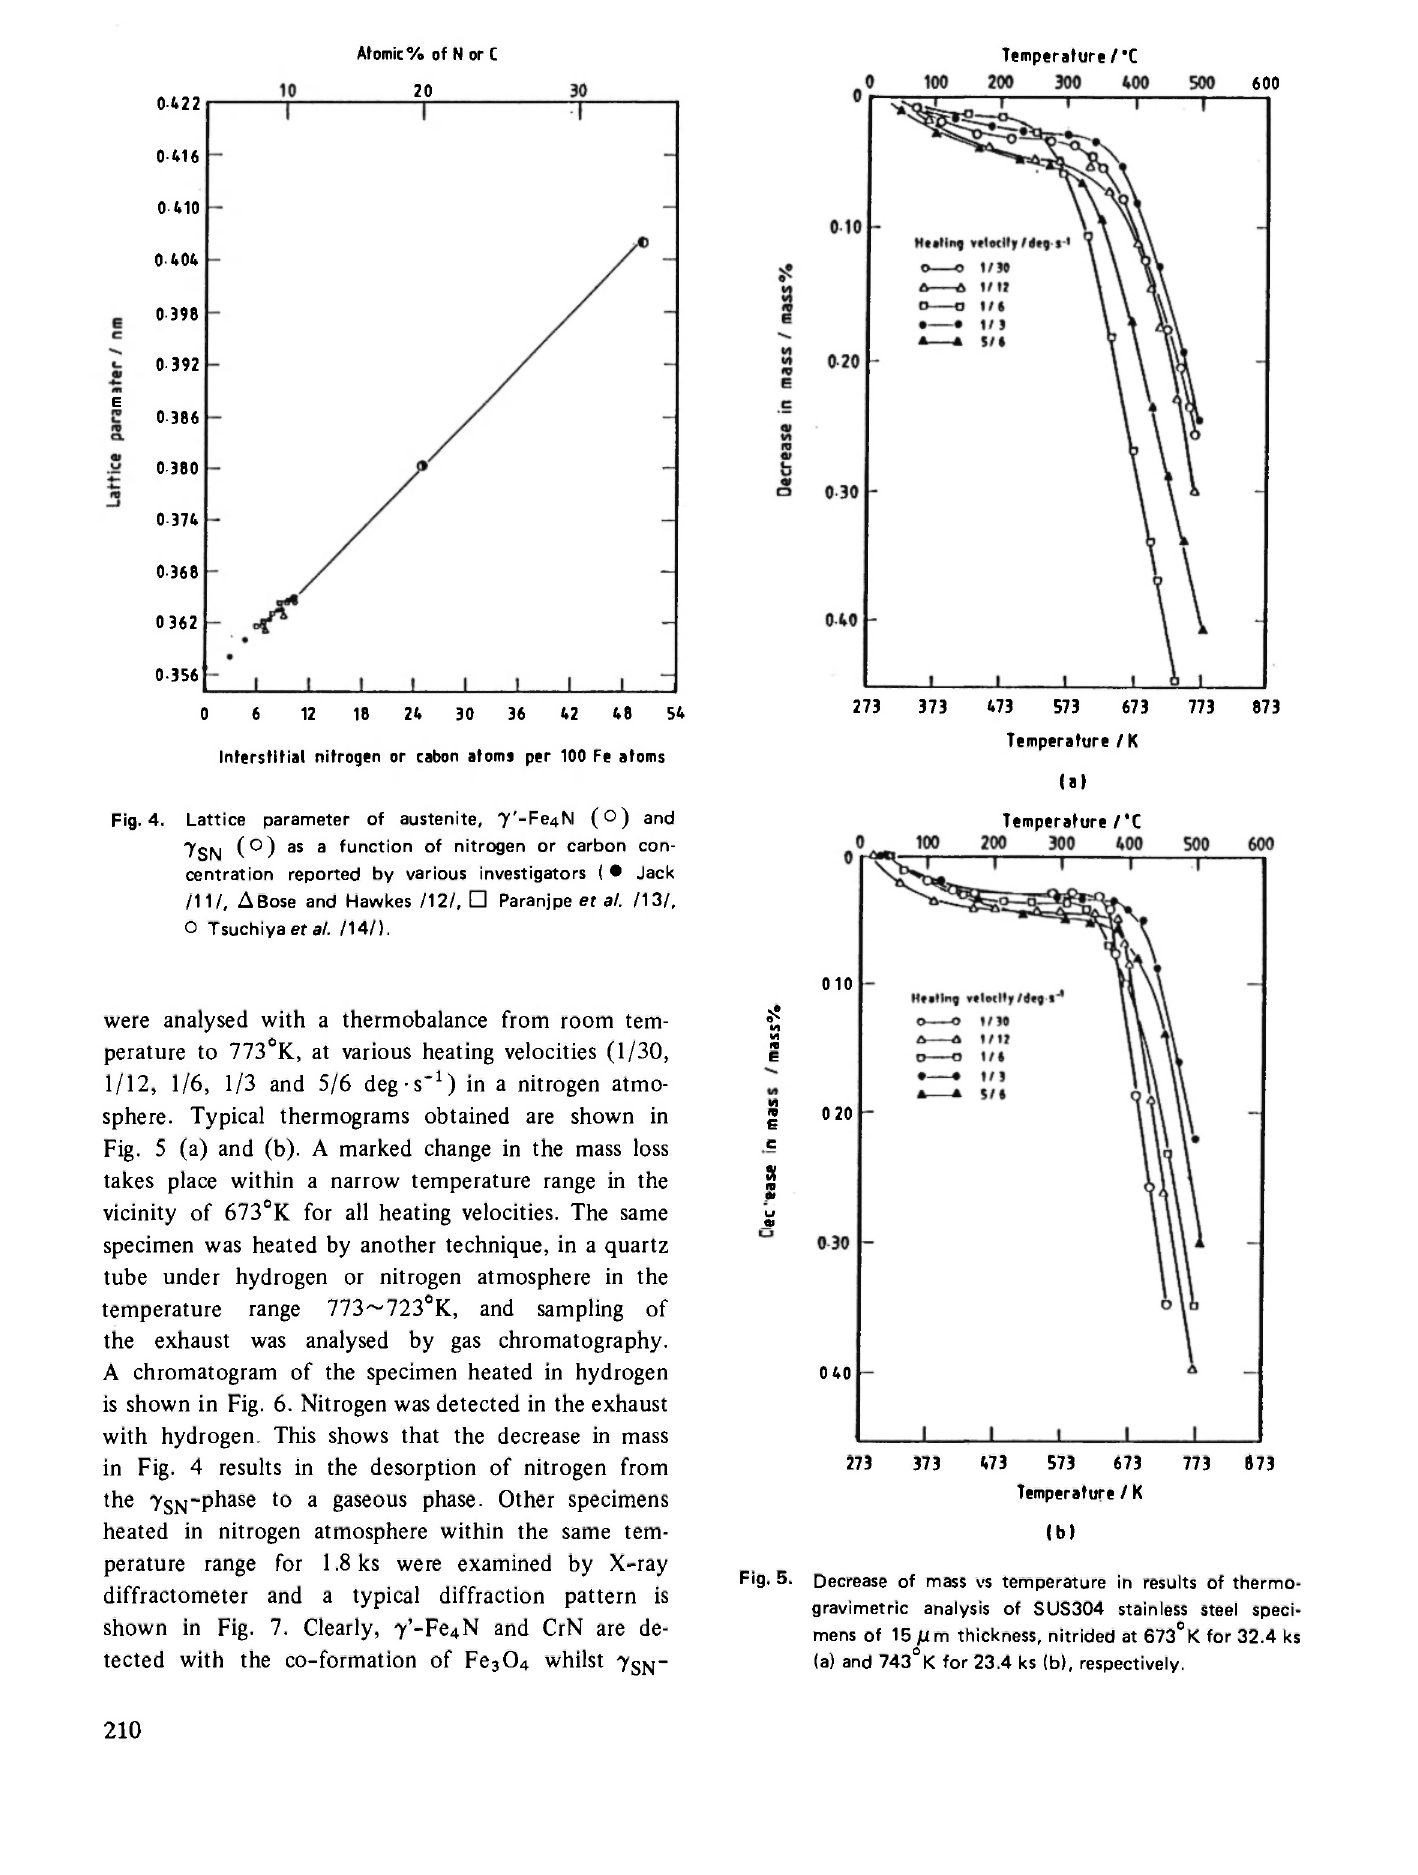
Fig. 4. Lattice parameter of austenite, 7'-Fe4l\l ( o) and TSN ( °) as 3 f u n c t i on of nitrogen or carbon con-